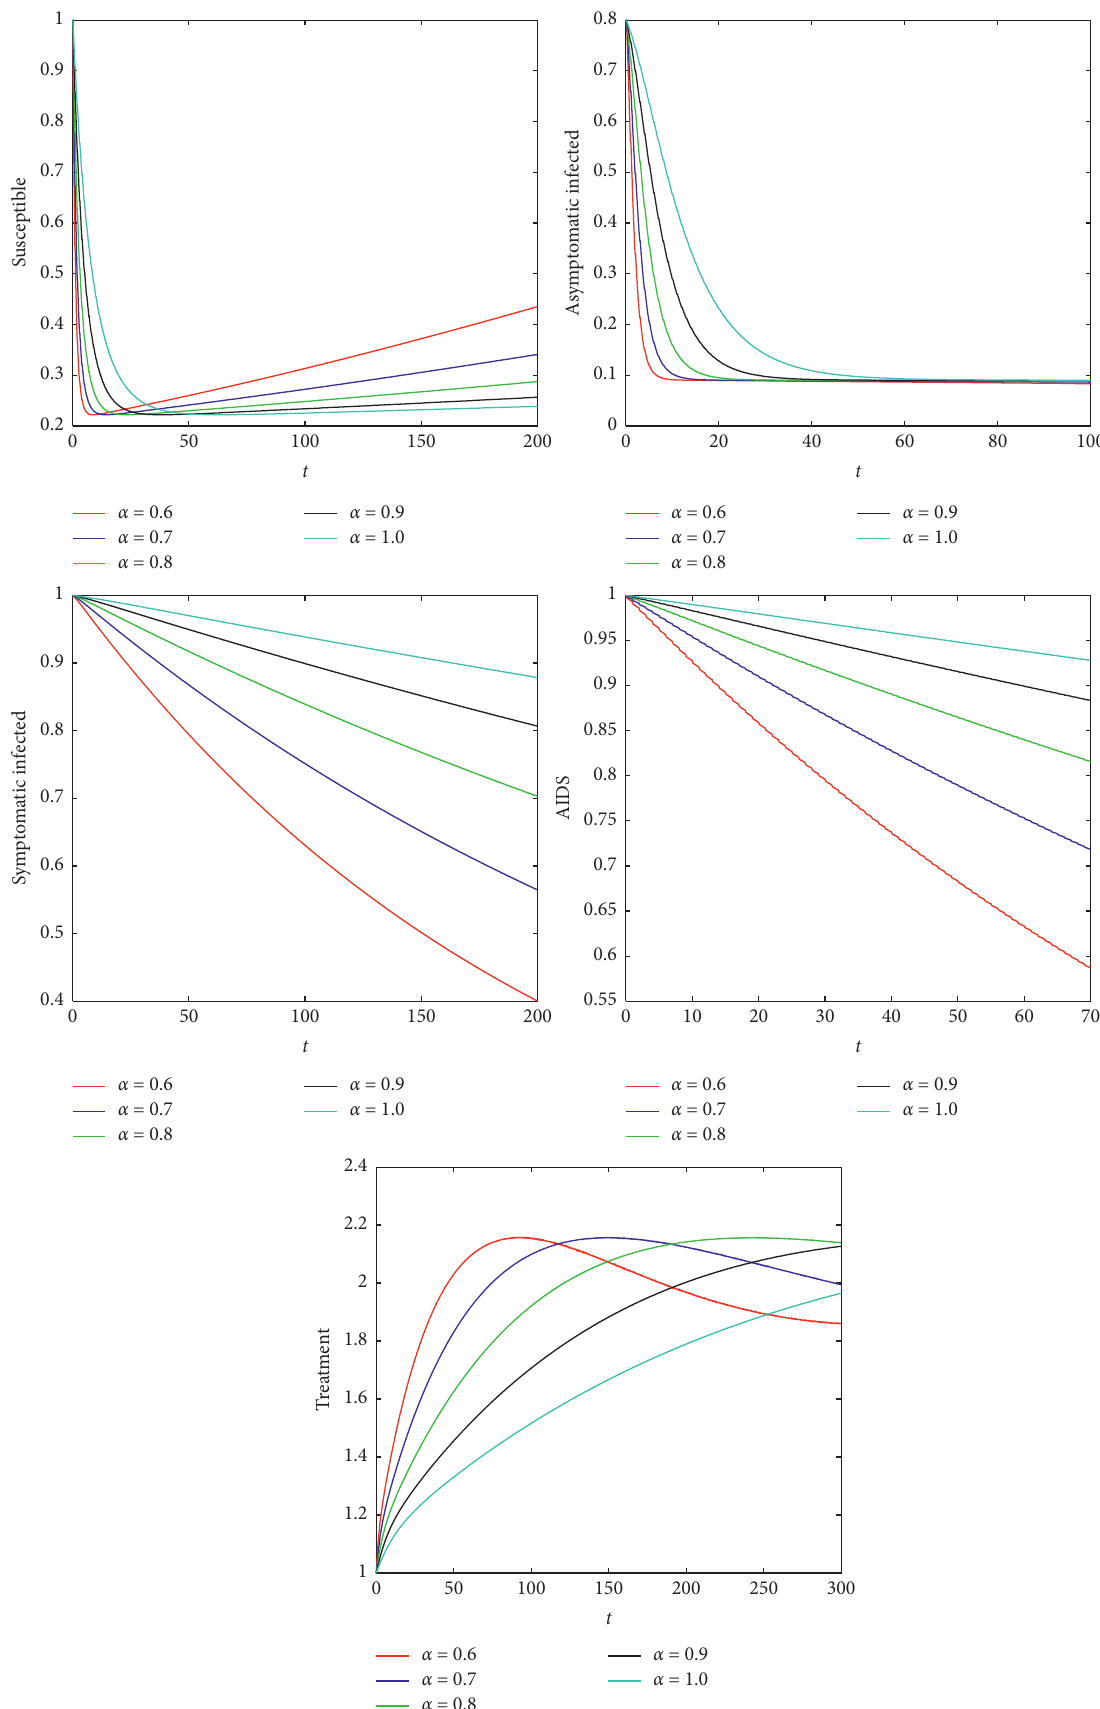
Figure 4: The dynamics of system (22) for different fractional order α